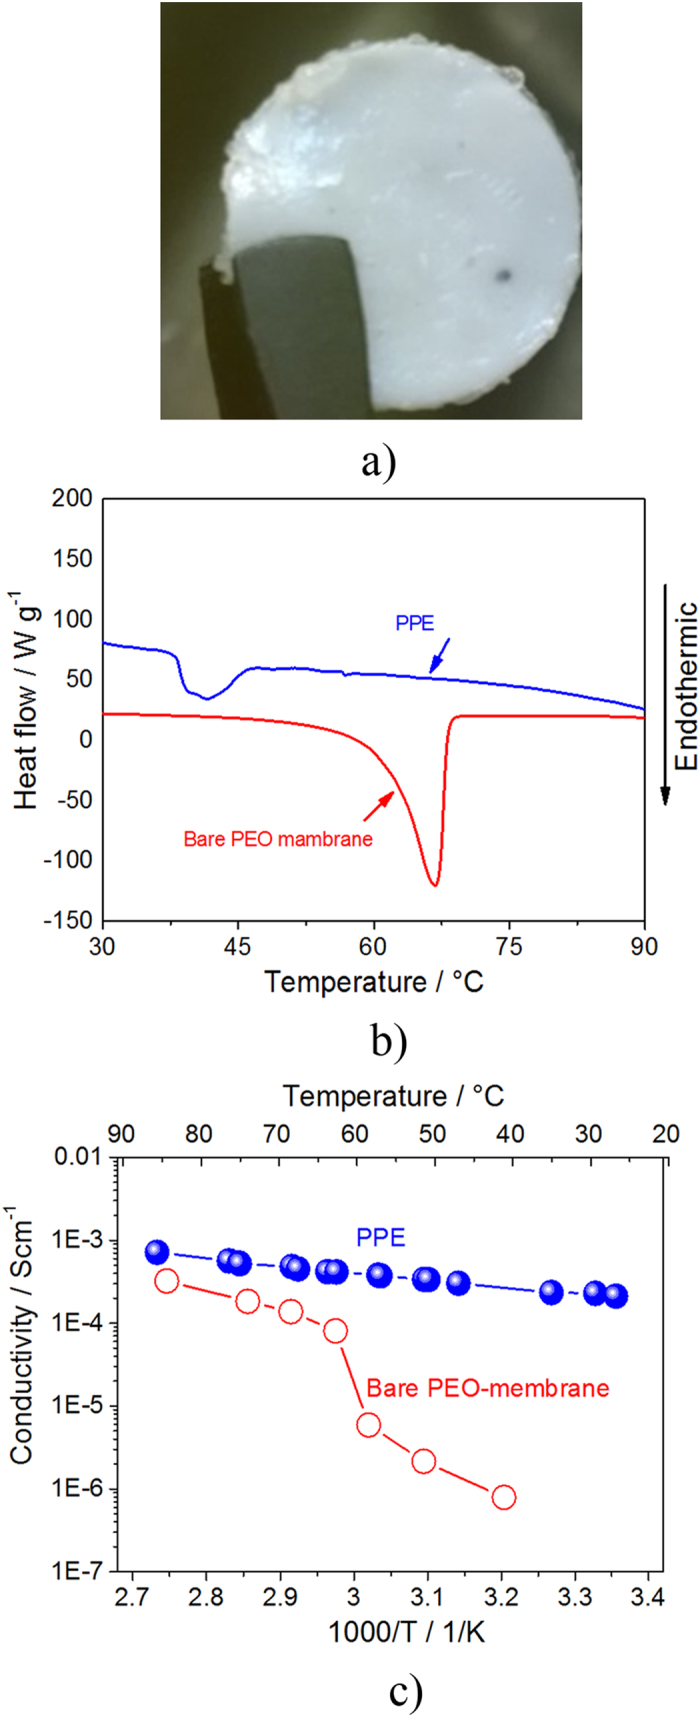
(a) Photographic image of the plasticized polymer electrolyte (PPE). (b) Differential Scanning Calorimetry (DSC) traces and (c) Arrhenius plots within 25 °C and 95 °C of the of the bare PEO20LiCF3SO3-ZrO2 membrane (red curves) and of the plasticized polymer electrolyte (PPE, blue curves).